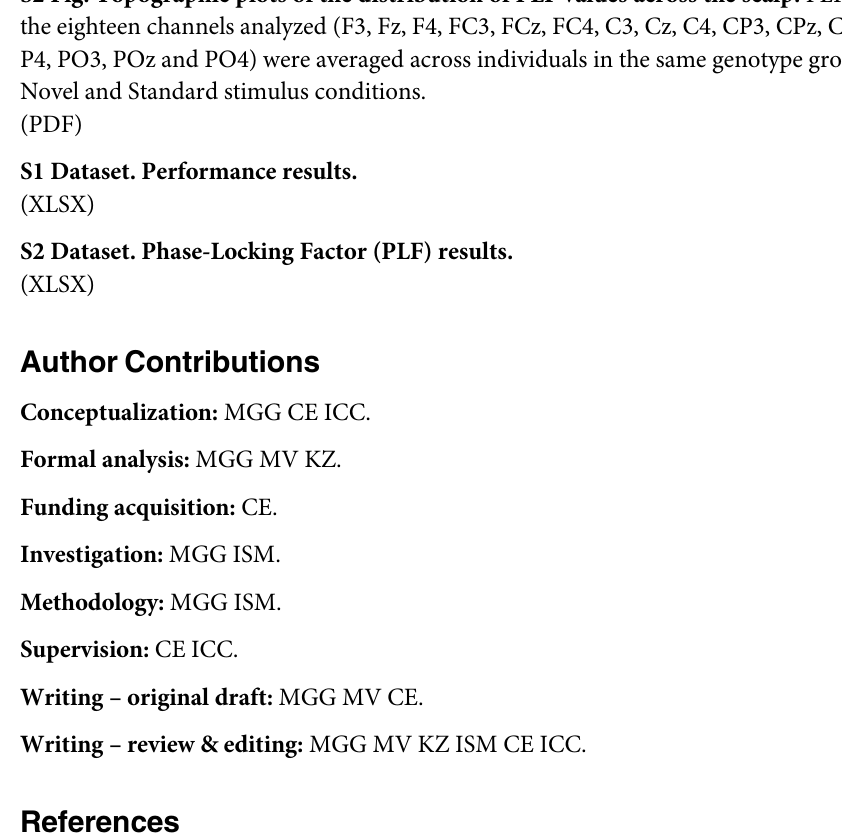
S1 Fig. Schematic of the task. S2 Fig. Topographic plots of the distribution of PLF values across the scalp. PLF values in the eighteen channels analyzed (F3, Fz, F4, FC3, FCz, FC4, C3, Cz, C4, CP3, CPz, CP4, P3, Pz, P4, PO3, POz and PO4) were averaged across individuals in the same genotype group for the Novel and Standard stimulus